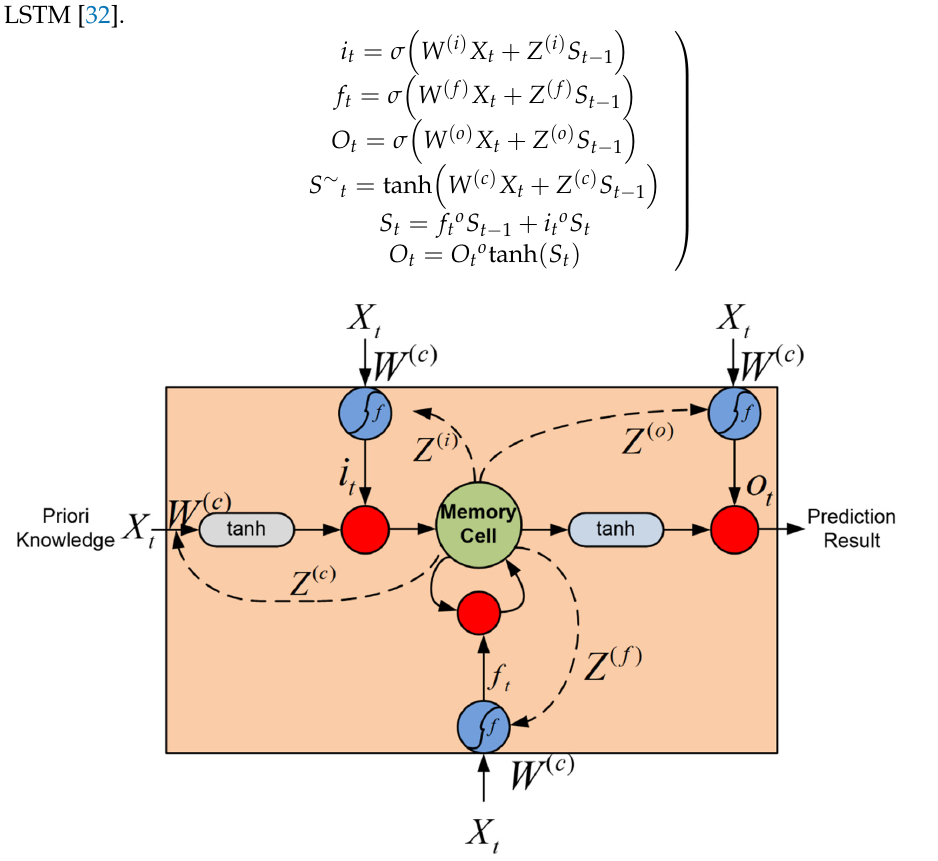
Figure 4. Architecture of LSTM.